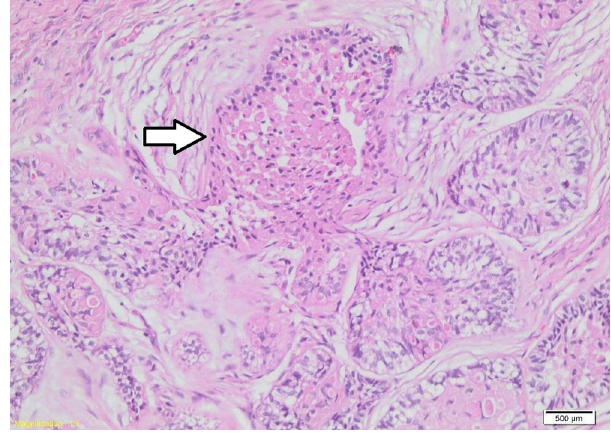
Fig. 8. H&E stained specimen showing follicular ameloblastoma with granular cell